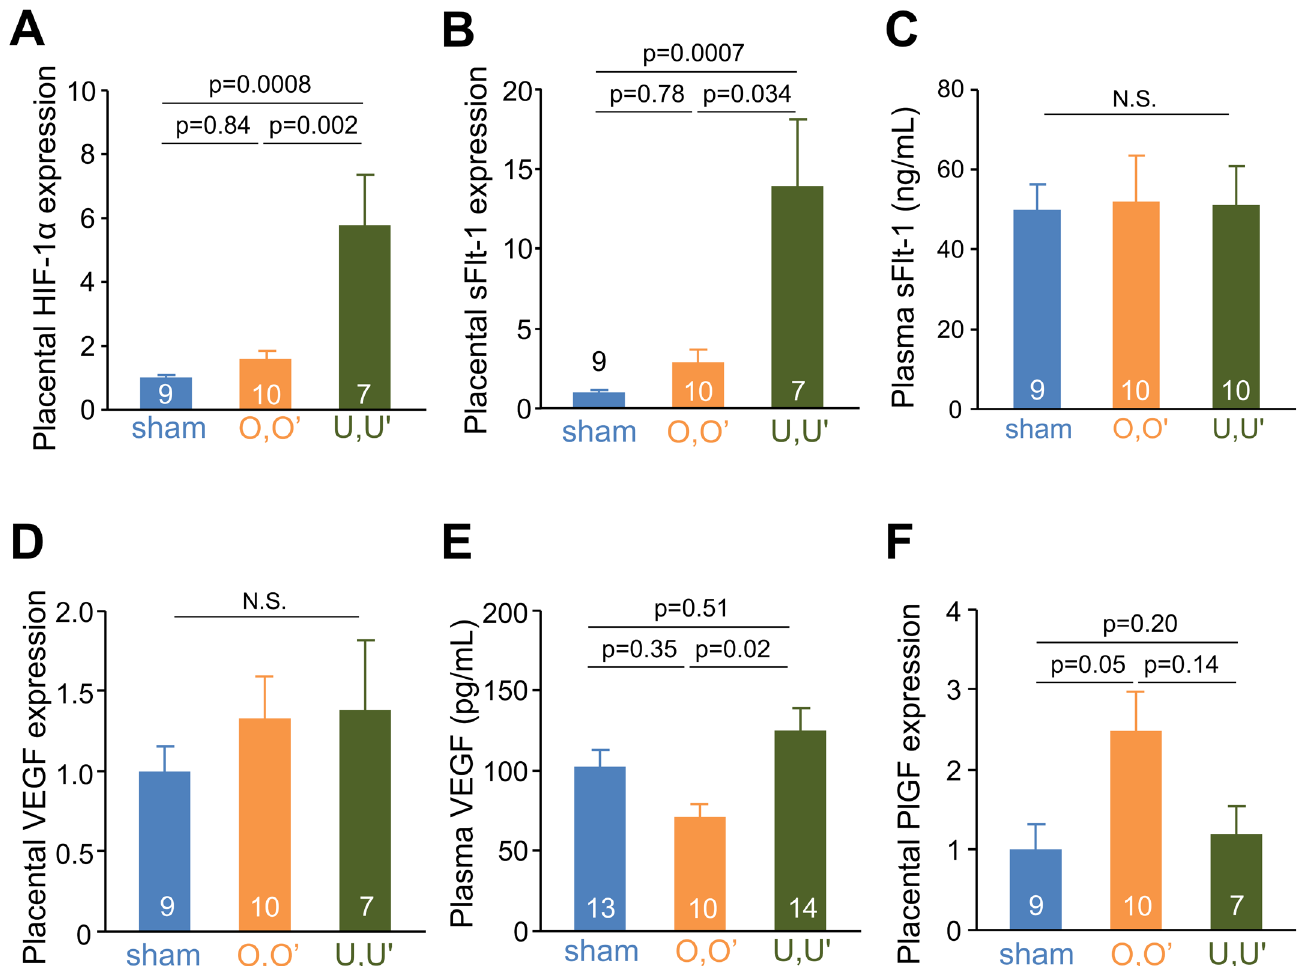
Fig 5. Hypoxia by RUPP increases placental sFlt-1 expression. mRNA expression of HIF-1 α ( A ), sFlt-1 ( B ), VEGF ( D ), and PlGF ( F ) in placentae at 18.5 dpc. Plasma concentrations of sFlt-1 ( C ) and VEGF ( E ) at 18.5 dpc dams.